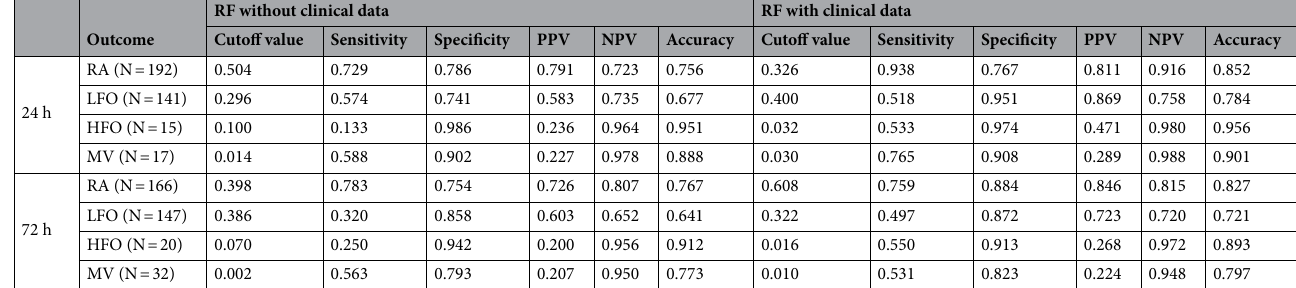
Table 2. Performance metrics for prediction of oxygen requirement in patients with COVID-19 using the CXR xAI model with and without clinical information. RF random forest, RA room air, LFO low flow oxygen, HFO high flow oxygen and MV mechanical